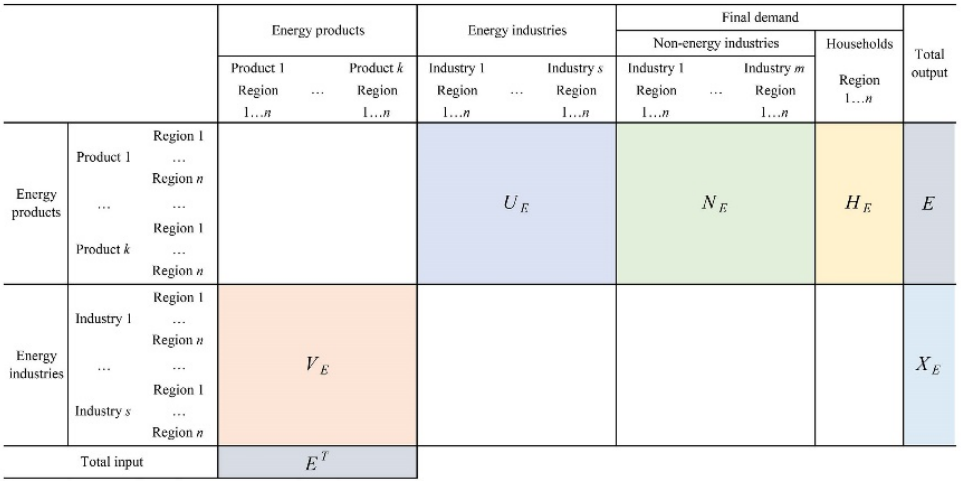
Figure A2. Structure diagram of the GEMRSU table.